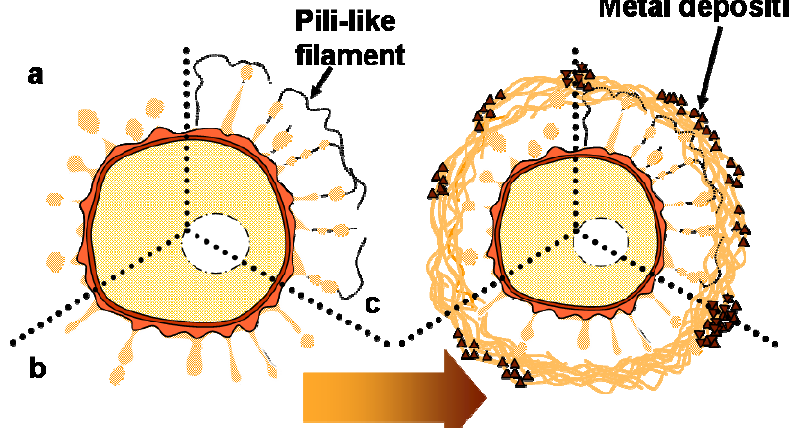
Figure 4. Working model of the initial phase of the assemblage of fibrils composed of bacterial secretions that form the immature sheath skeleton of cultured OUMS1. Bacterial secretion from the cell envelope may occur by ( a ) direct globular secretion; ( b ) direct thread secretion; and/or ( c ) indirect secretion via a pili-like mechanism. The secretion might be transported outwards to form the fibril assembly of the sheath skeleton, followed by aqueous-phase inorganic element